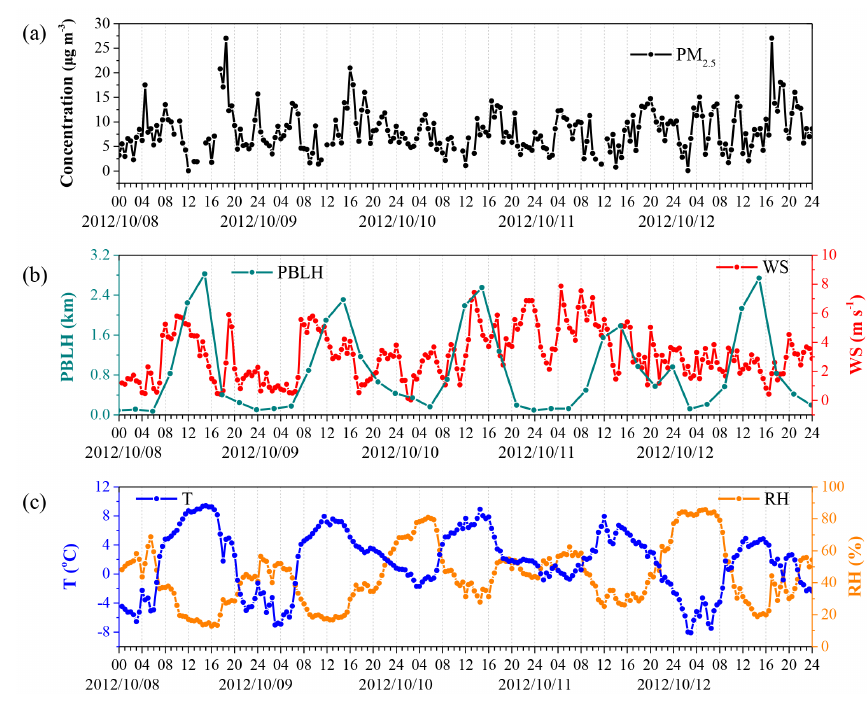
Figure 10. Diurnal variations in PM 2 . 5 concentrations and related environmental factors for 8–12 October 2012 at the Nam Co station. Based on local time (LT), 30min mean datasets were